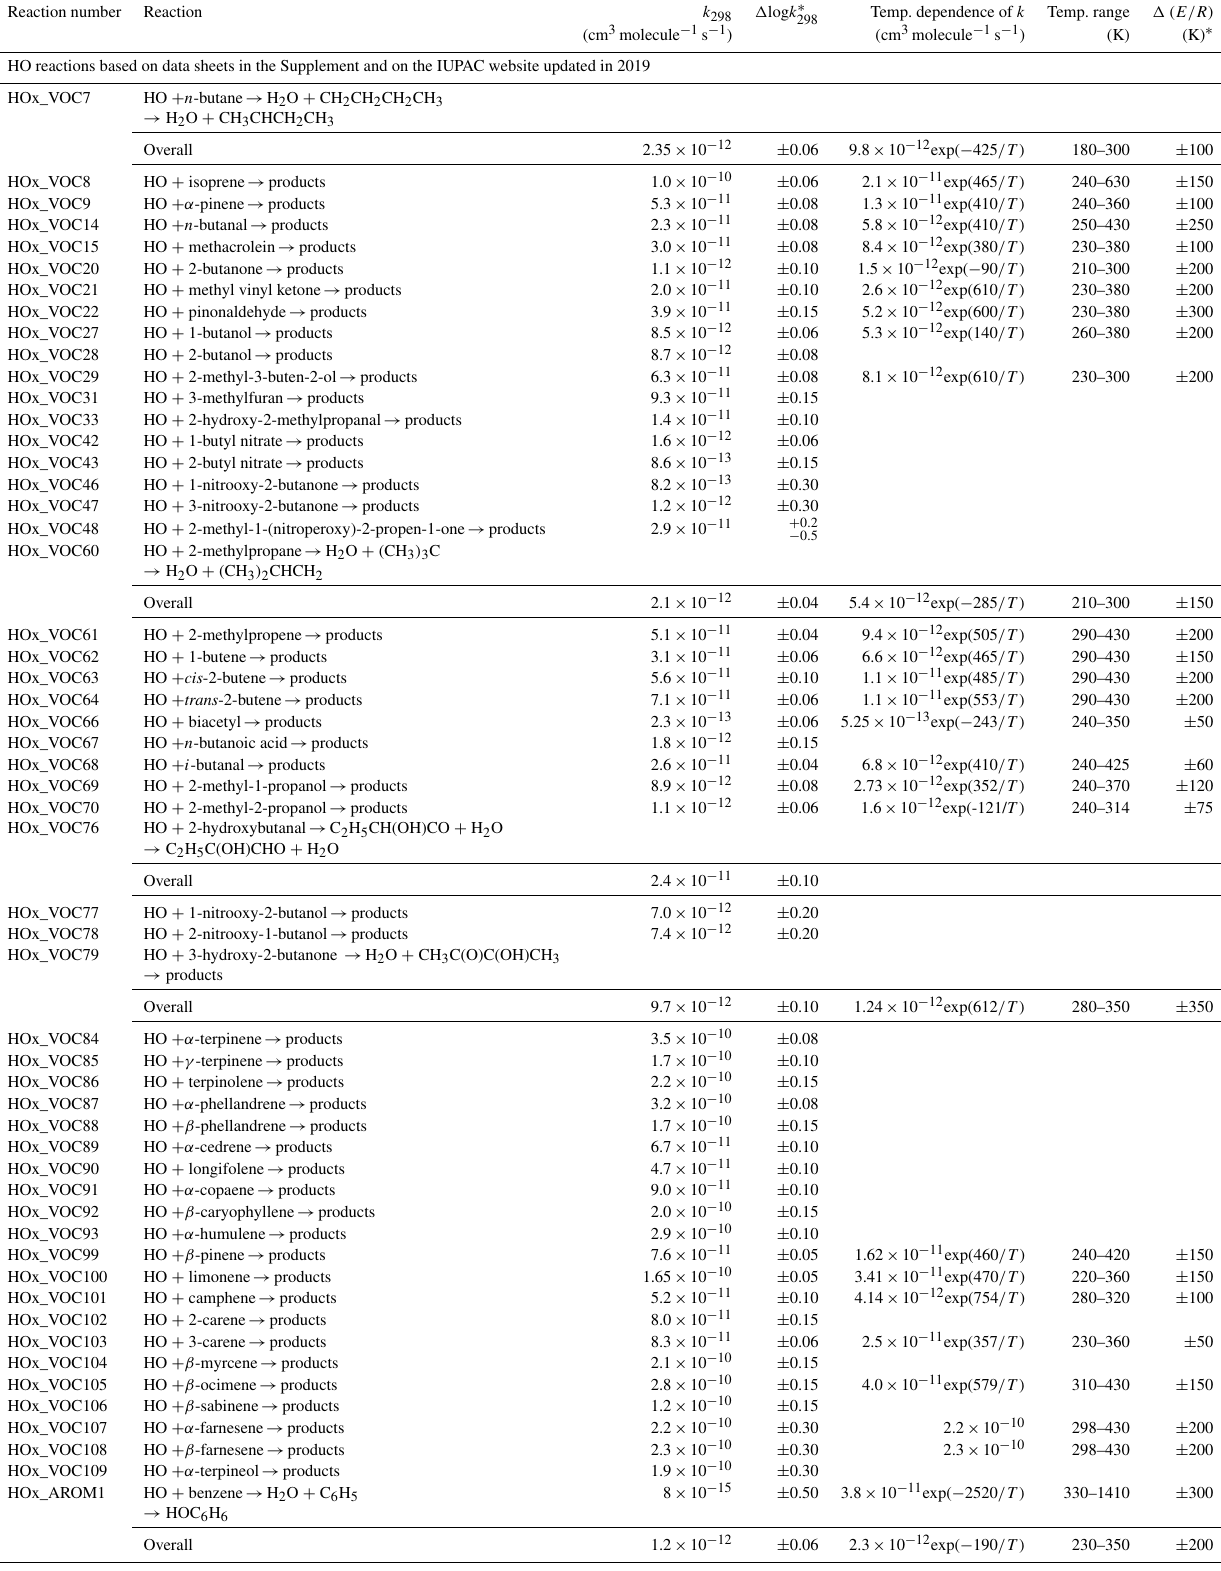
Table 1. Summary of recommended rate coefficients for organic ( ≥ C 4 ) reactions. Reaction number